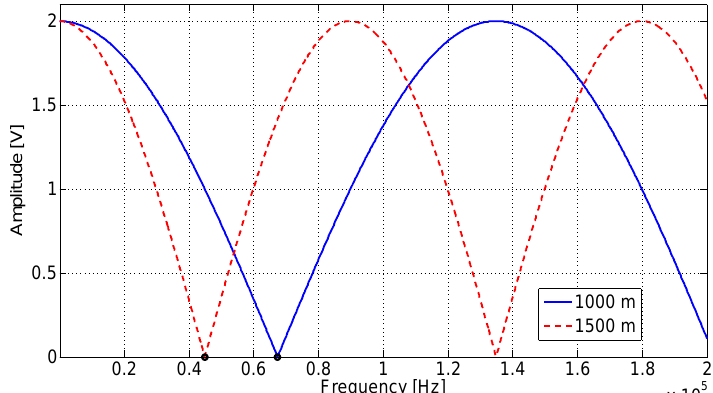
Figure 7. Behavior of the observed amplitude B with respect to the frequency as in (22). Open circuit at 1000 m and 1500 m. The velocity of propagation v is considered as 90% the velocity of light and the frequency bandwidth is 100 Hz up to 200 kHz. The frequency was varied in steps of 100 Hz. The dots marked with a circle correspond to the identification of the